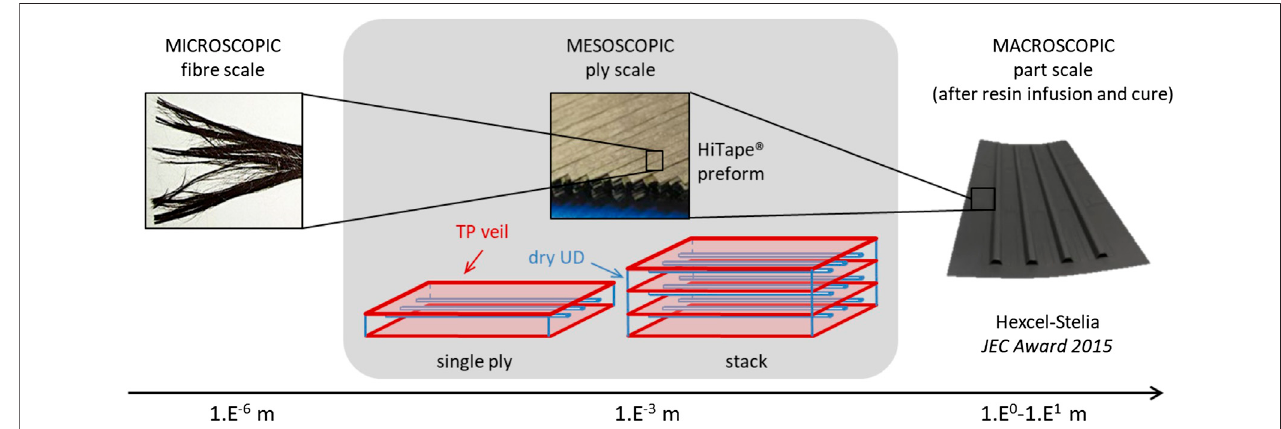
FIGURE 2 | The three main scales of observation of composites materials; an intermediate (mesoscopic) ply scale is selected for forming modeling and HiTape ® characterization.